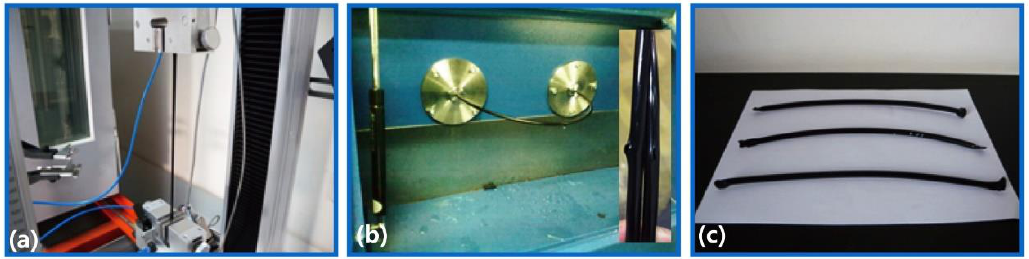
Figure 2. The measurements of ( a ) tensile loading, ( b ) burst pressure and ( c ) fuel permeability for the fuel pipes of automobiles.